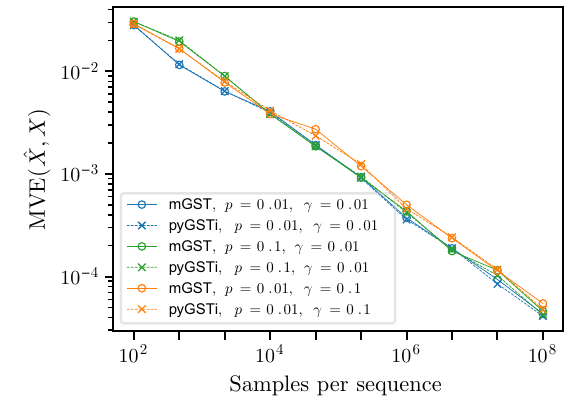
FIG. 2. Reconstruction of the XYI gate set for different lev- els of depolarizing noise with strength p and unitary noise with strength γ on each gate. The unitary noise is given by e i γ H with H ∼ GUE. Additional depolarizing noise with p = 0.01 is applied before measurement. The mGST algorithm is run on the loglikelihood cost function with r K = 4 (max), which is the same as for pyGSTi . As gate sequences, we again used the standard pyGSTi fiducial sequences, with the number of measurements per sequence between 10 2 and 10 8 . The lines connect data points of which each is the median over ten runs. For each run, a new random over-rotation is drawn and new measurements are simu- lated. The measurement sequences are the 92 sequences provided by the pyGSTi software, with a maximum sequence length of (cid:2) ≤